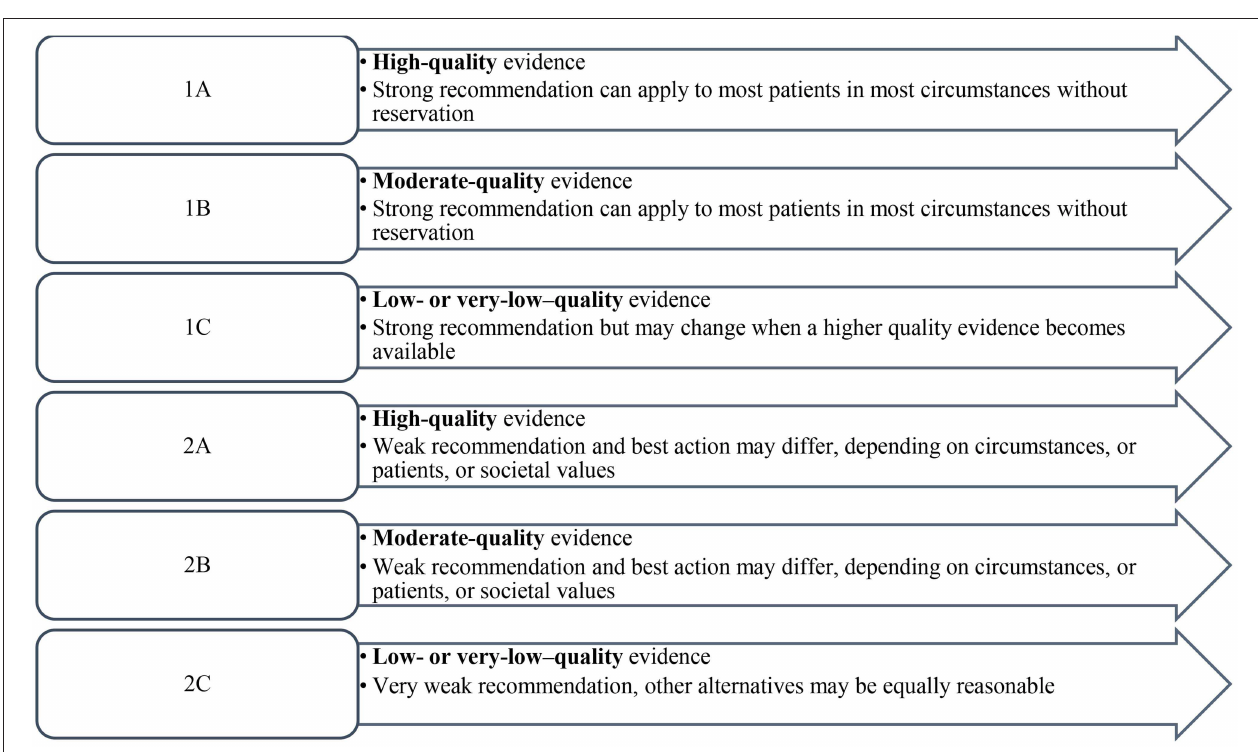
FIGURE 1 | Level of evidence and strength of recommendation.